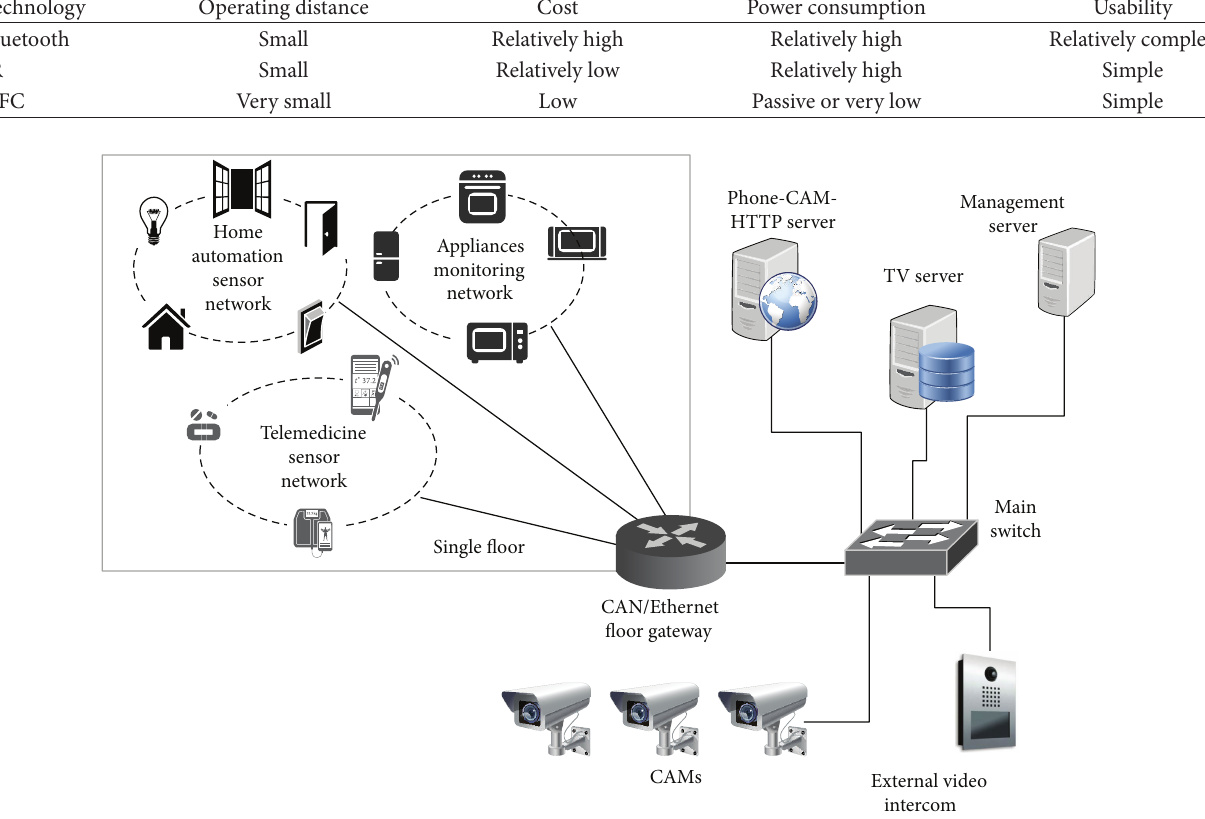
Figure 1: The reference home automation system